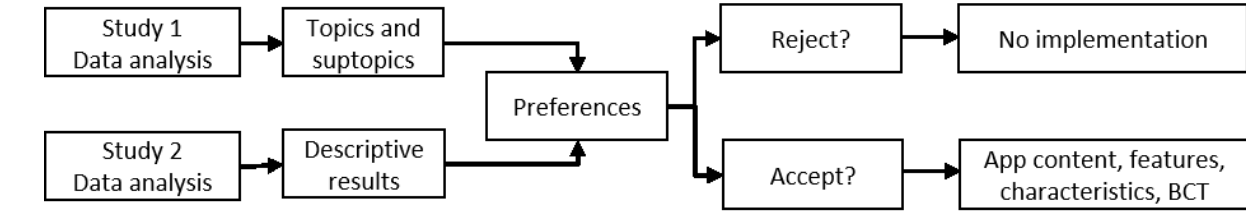
Figure 2. Process of identification of relevant target group preferences. BCT: behavior change